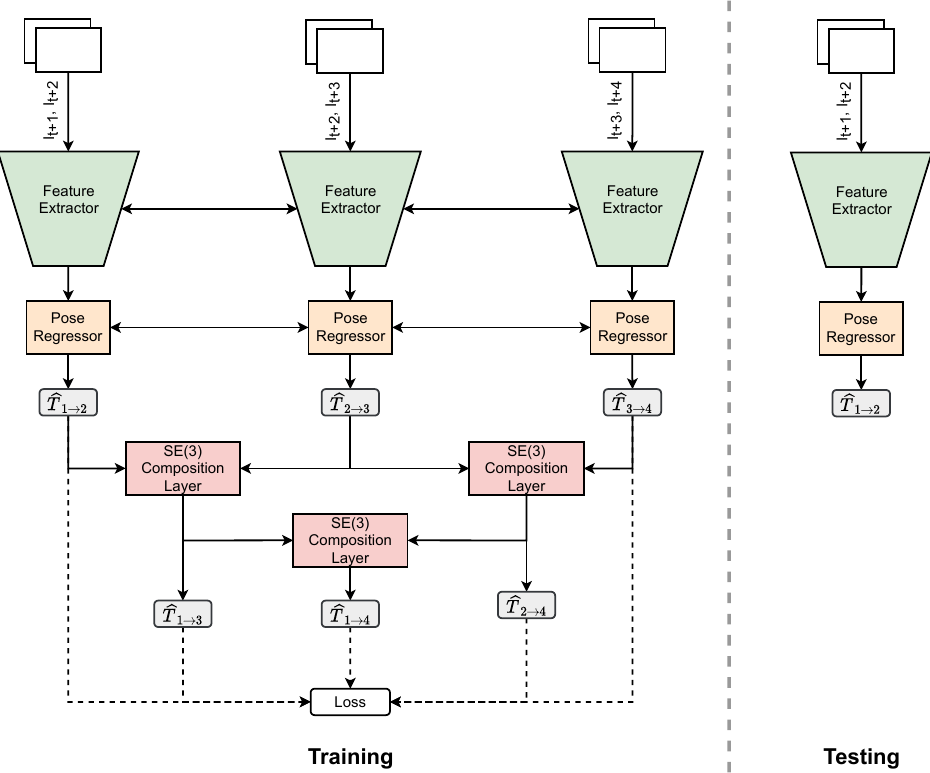
Figure 1. Overview of the WPO-NET. SE ( 3 ) composition layer is used to derive the composite poses from predicted